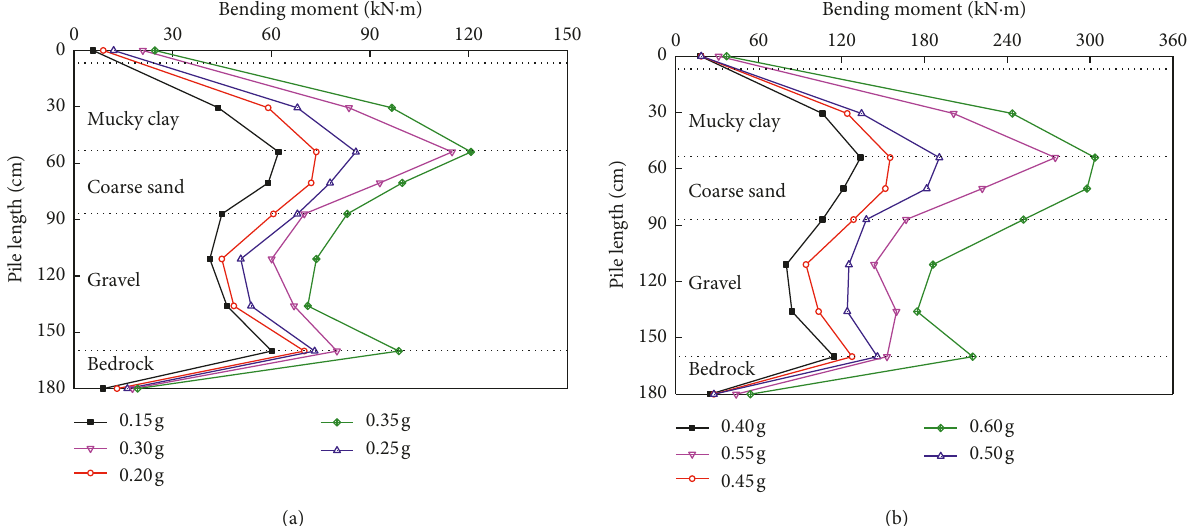
Figure 16: The bending moment of the pile for different seismic intensities: (a) seismic intensity of 0.15g–0.35g; (b) seismic intensity of 0.40g–0.60g.